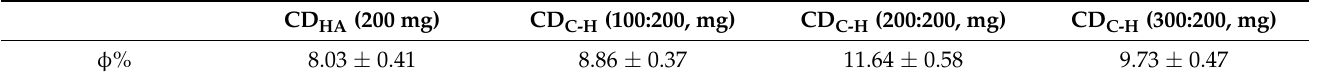
Table 1. The fluorescence quantum yield ( φ ) of the CD C-H at different mass ratios (n = 3, date present mean ±